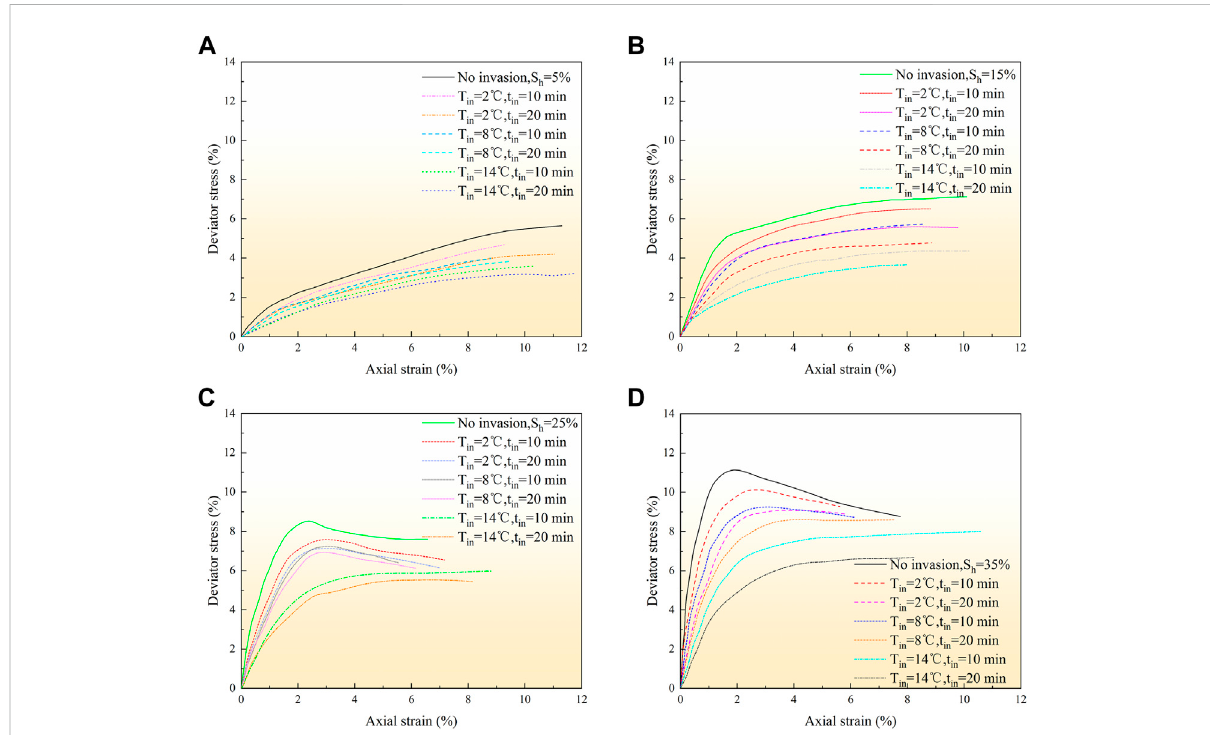
FIGURE 10 Stress-straincurveofhydrate-bearingsedimentafterdrilling fl uidinvasion. (A) Thestress-straincurvewith5%hydratesaturation. (B) Thestress- strain curve with 15% hydrate saturation. (C) The stress-strain curve with 25% hydrate saturation. (D) The stress-strain curve with 35% hydrate saturation.